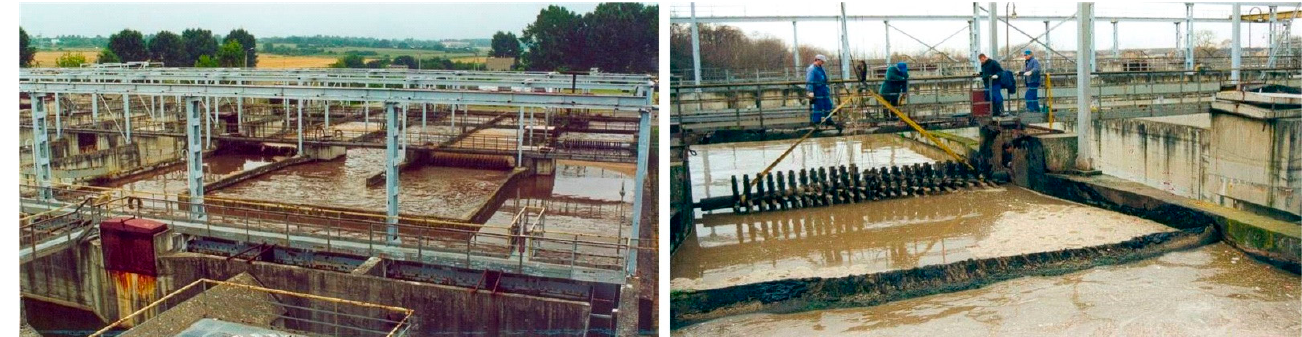
Figure 1. Archival photographs of the biological reactor in the 1990s.